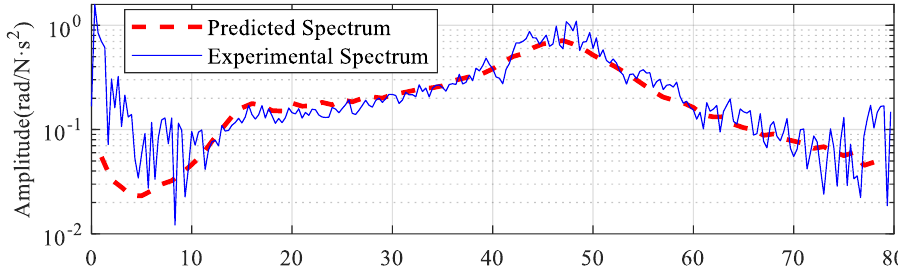
Figure 12. Comparison of predicted spectrum and actual spectrum.